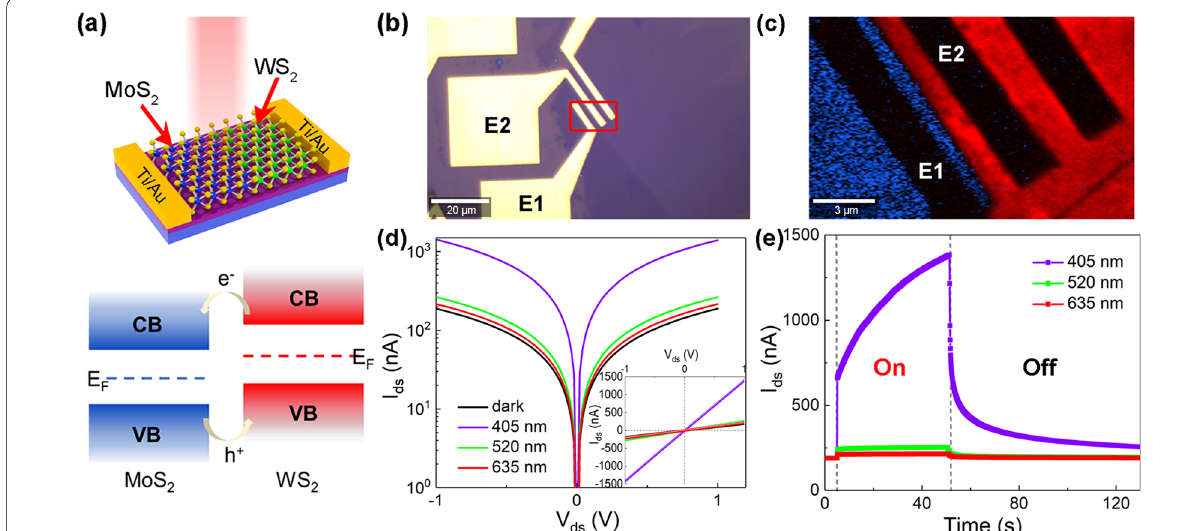
Fig. 2 Optoelectronic characteristics of the photodetector. ( a) The schematic diagram and proposed band alignment of the photodetector. The optical image ( b ) and corresponding combined Raman mapping ( c ) of the photodetector. E1 and E2 represent the source and drain electrodes of the measured device. The semi-logarithmic ( d ) and linear (inset of ( d) ) I – V characteristics and the photoswitching characteristics ( e ) of the